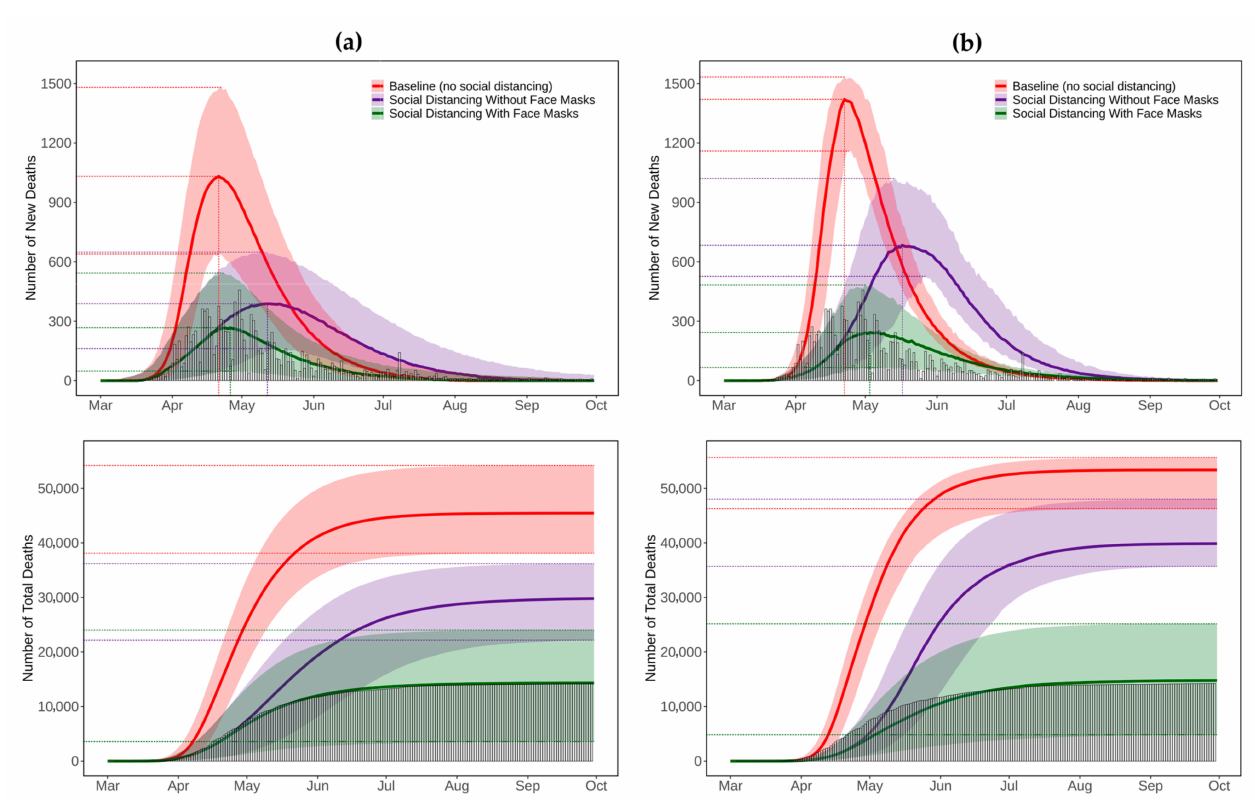
Figure 10. Comparison of projected trajectories of new/total deaths from COVID-19 calculated for different exposure scenarios with reported death data (vertical bars) for New Jersey using ( a ) summation of predictions from 21 county-level SEIR models, and ( b ) predictions from the statewide SEIR model. The color-shaded areas depict the 95% Confidence Interval (CI) of the corresponding